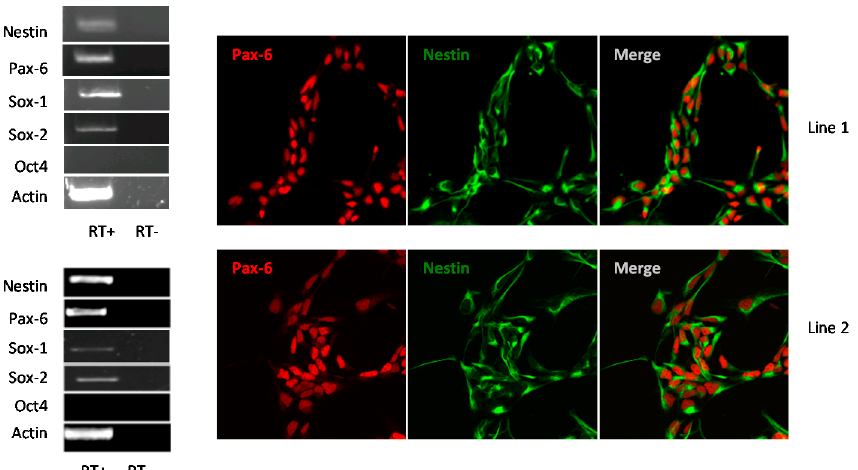
Figure 1. Characterization of induced pluripotent stem cell (hiPSC)s-derived neural stem cells (NSCs) lines 1 and 2: RT-PCR analysis of NSCs markers PAX6, NESTIN, SOX1, SOX2, the negative control OCT4 and the housekeeping gene ACTIN ; confocal imaging of NSCs immunolabeled for the neural progenitor markers Pax6 and Nestin. NSC Lines 1 and 2 are shown at 60 × magnification. RT: Reverse transcriptase.